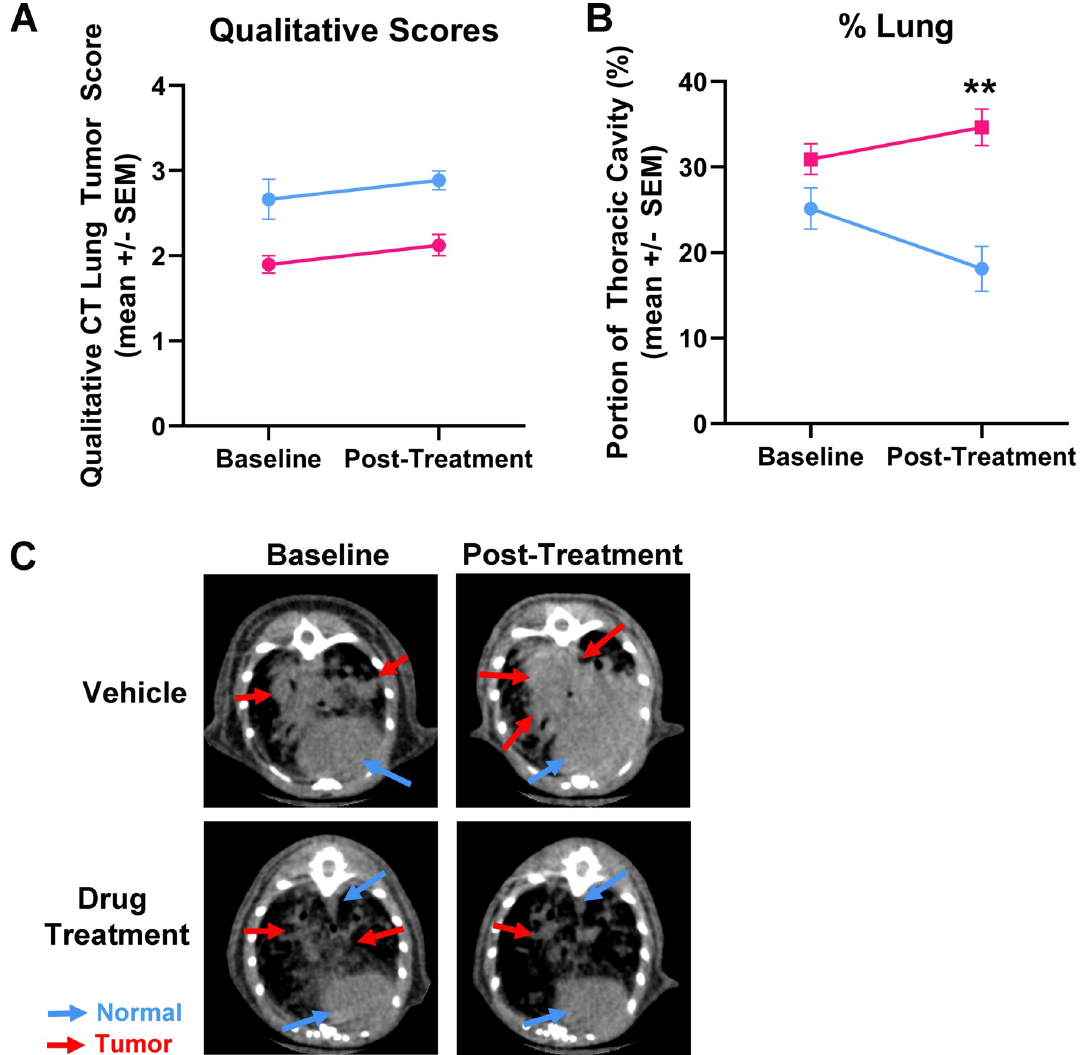
Fig 6. Utility of MLAST in an efficacy trial using Kras/Lkb1 GEM model. (A) Manual scores assigned to scans from vehicle control (blue) and drug treatment (pink) groups before (baseline) and 3 weeks post-treatment regimen. (B) MLAST scores from vehicle (blue) and drug treatment (pink) groups before and post-treatment regimen. (C) Representative images from vehicle control and drug treated groups before and post-treatment. Images show profound progression of tumor in vehicle control group, but not in drug treated group. (n = 10/group; +/- SEM; �� = p-value <